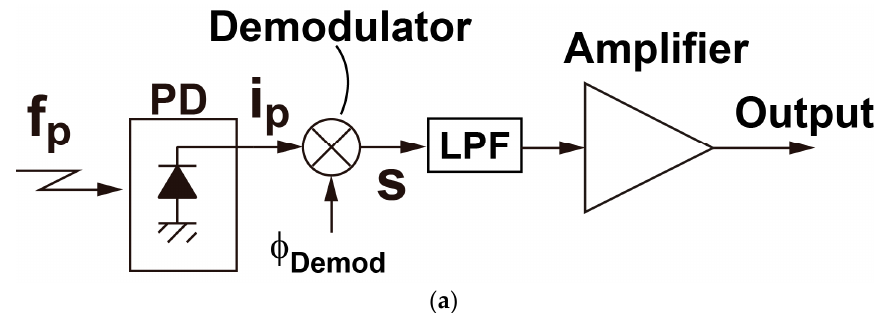
Figure 3. Cont. Figure 3. Cont.